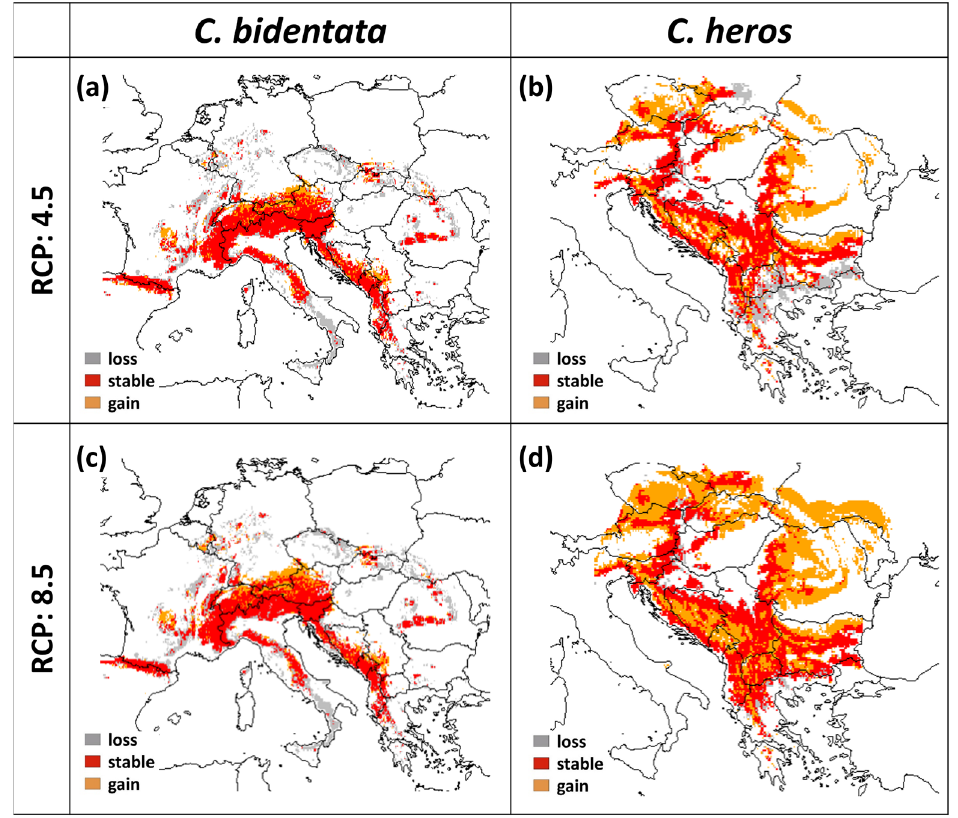
Figure 4. Changes in future projections under di ff erent climatic scenarios (for the year 2070) for ( a ) C. bidentata under RCP 4.5, ( b ) C. heros under RCP 4.5, ( c ) C. bidentata under RCP 8.5, and ( d ) C. heros under RCP 8.5 (red area: stable, orange area: gain, gray area: loss). Table 2. The changes in the size of suitable area in the number of pixels for the future projections. “Stable” areas were predicted to be suitable in both the present and future, “loss” is when the area is suitable in the present but not in the future, and “gain” is when the area is only suitable in the future.